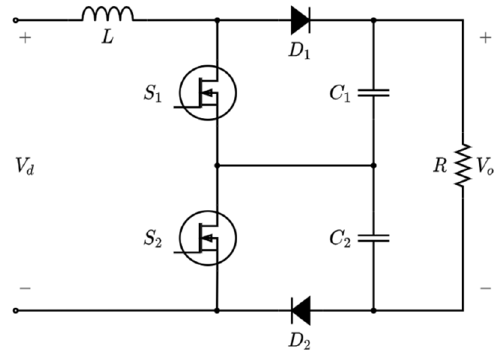
Figure 15. Non-isolated three-level DC/DC boost converter.